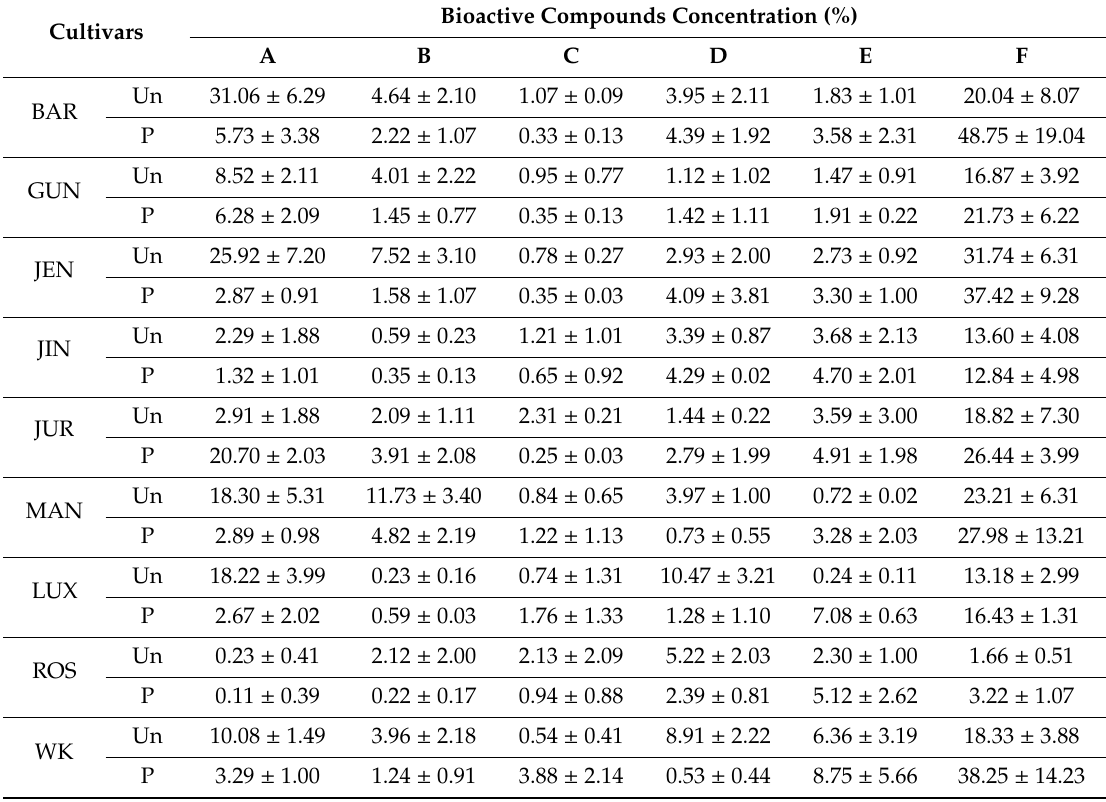
Table 2. Major bioactive compounds present in all of nine cultivars of unprocessed and processed lupin seed flours.